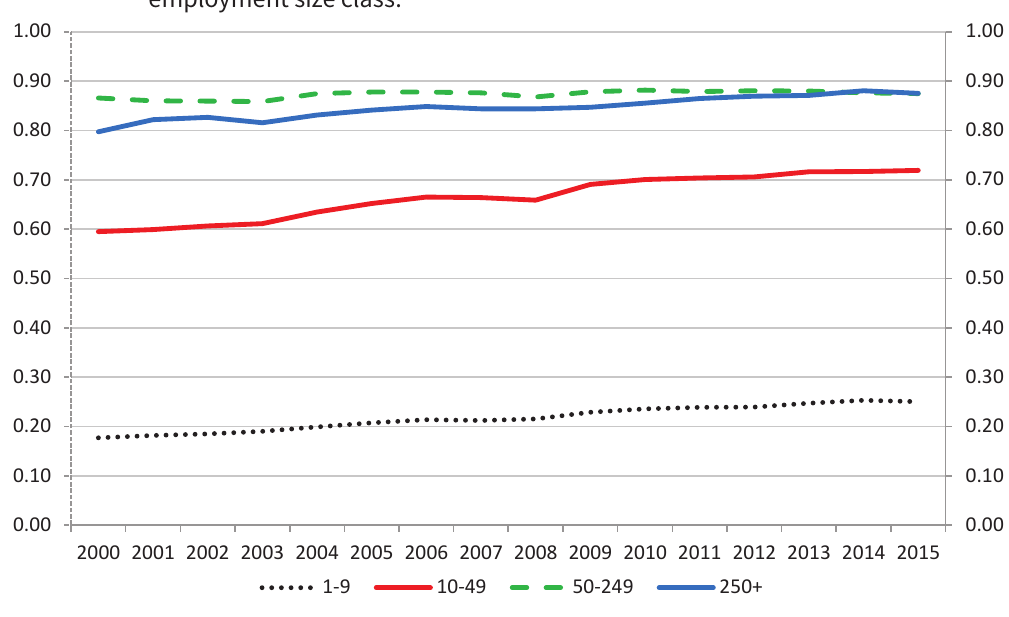
Figure A4 Percentage of firms in INPS with balance sheet information (from CERVED), by employment size